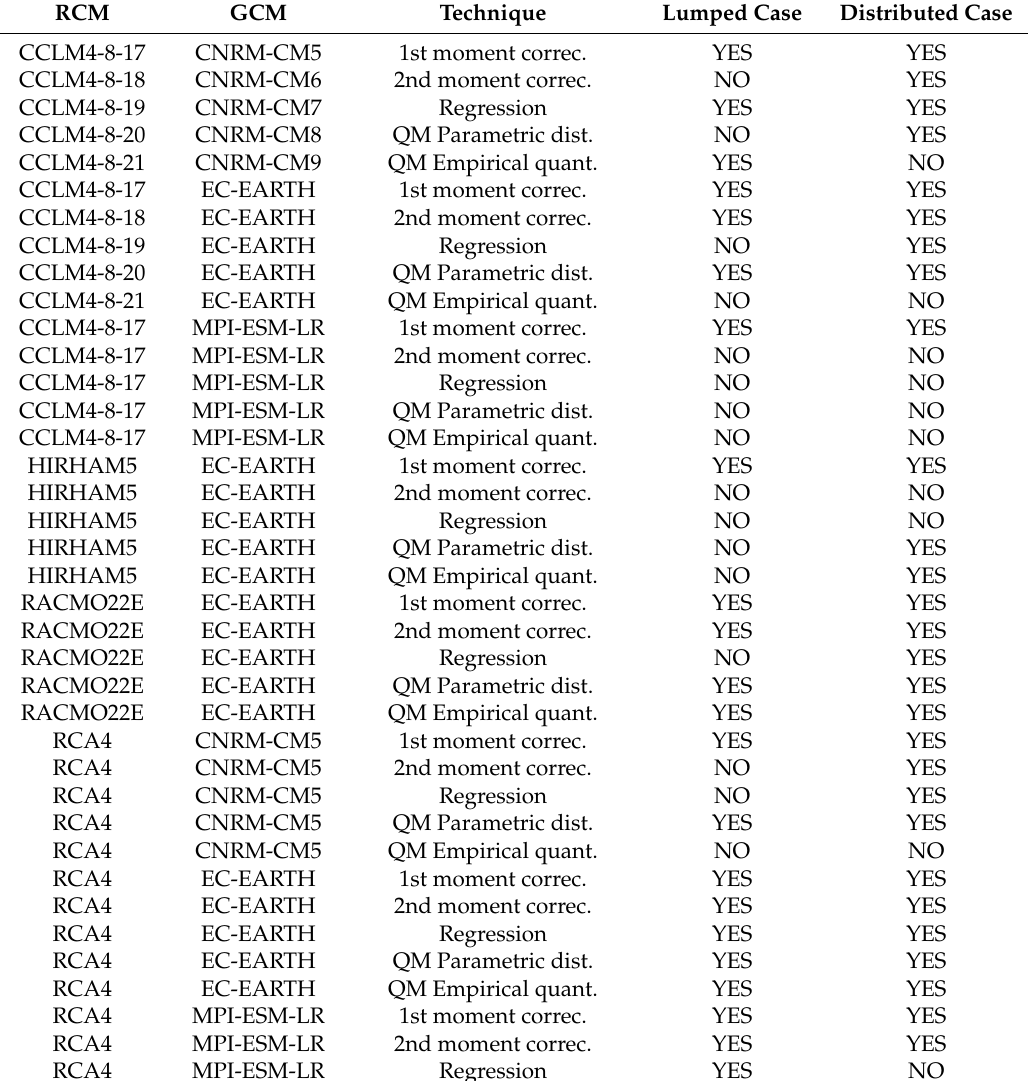
Table 4. Eliminated and uneliminated combinations of model and bias correction technique for the lumped and distributed